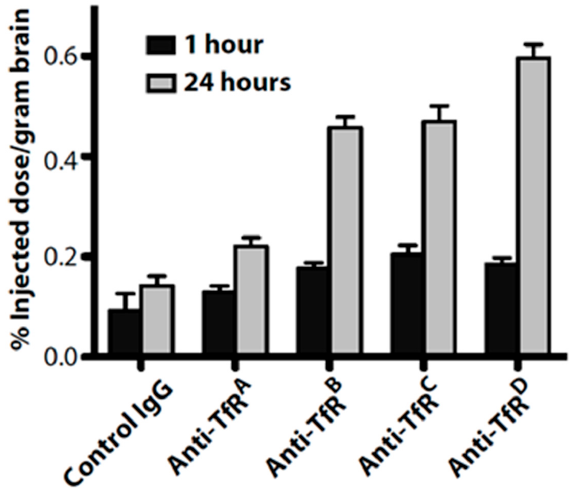
Figure 2. Lower-affinity anti-TfR D antibodies (A > D) at therapeutic doses show increased brain uptake. This figure is reproduced from Yu et al. (2013) with permission of the copyright owner [58].